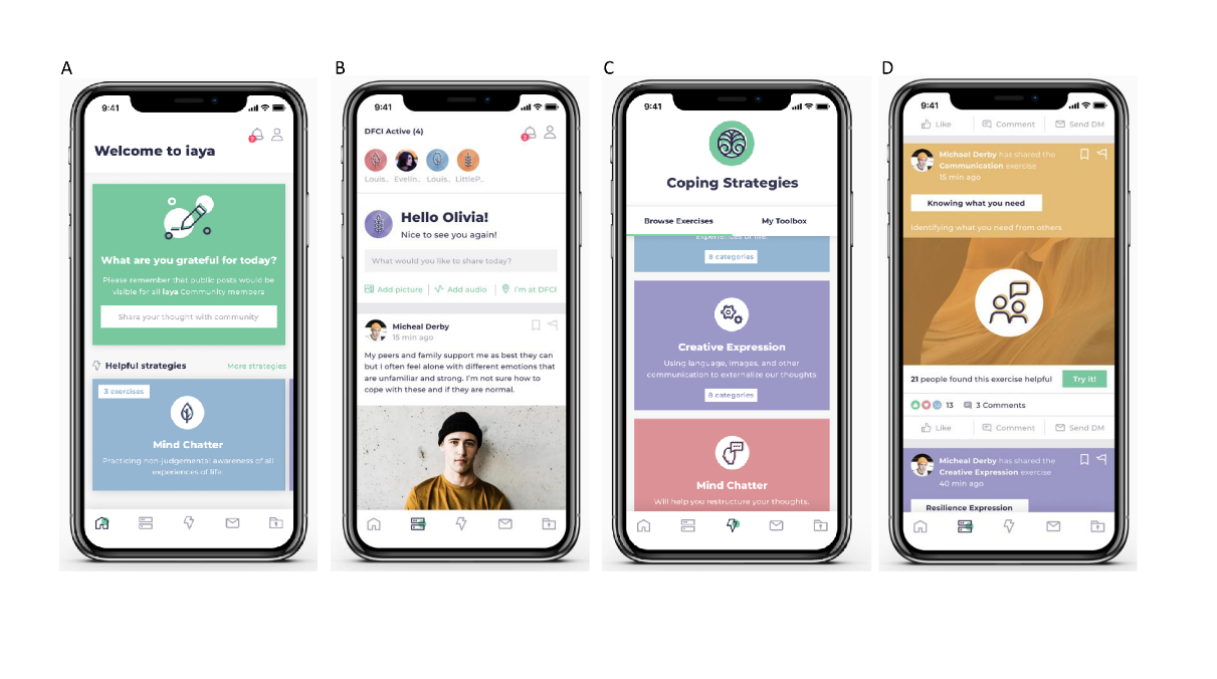
Figure 1. Features and interface of the iaya app. Main app features displayed on a (fictive) user’s smartphone, as follows: iPhone smartphone screens displaying the home page with a community question (A) and the community feed with active users on the web (B) and the option to check into the virtual waiting room through the geolocation feature “I’m at DFCI.” iPhone smartphone screens displaying the community feed with a user’s shared output from a coping exercise (C) to which users can respond by liking, commenting, direct messaging, or trying it themselves and the coping strategies section (D) in which users have the option to browse exercises or go to “My Toolbox,” where they shortlisted previously completed exercises for easy access. DFCI: Dana-Farber Cancer